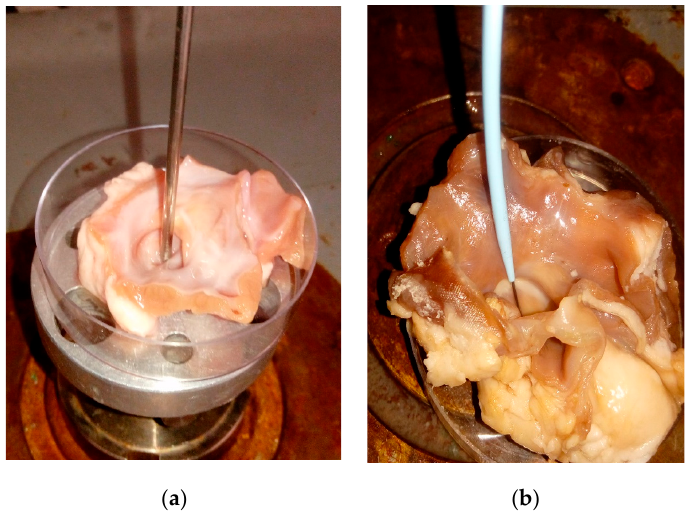
Figure 4. Indentation of fossa ovalis with ( a ) hemispherical indenter and ( b ) Brockenbrough